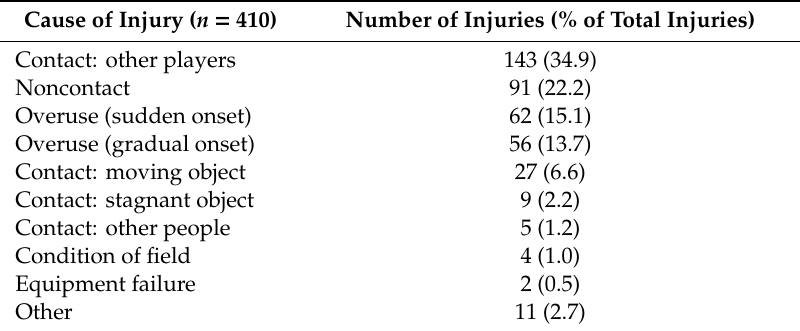
Table 6. Causes of injury in U-15 youth soccer during the 2019